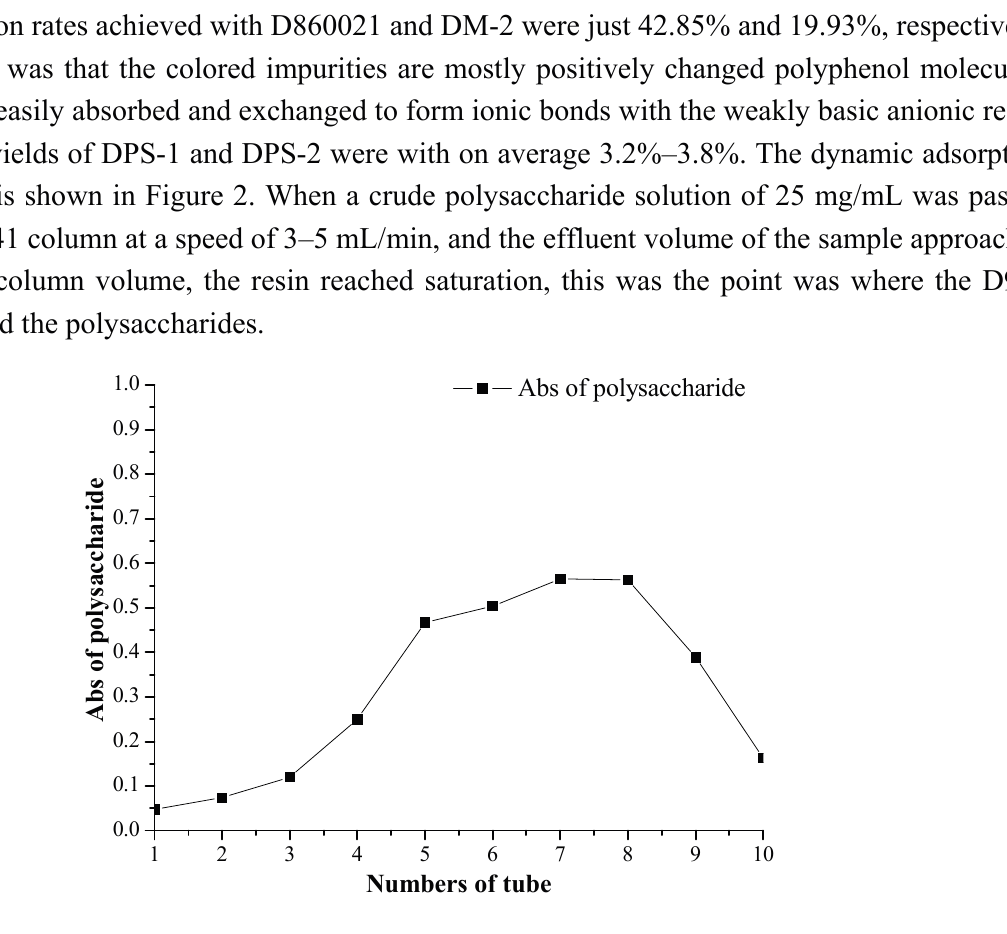
Figure 2. The dynamic adsorption of polysaccharide solution of Phyllostachys nigra (PN ) on